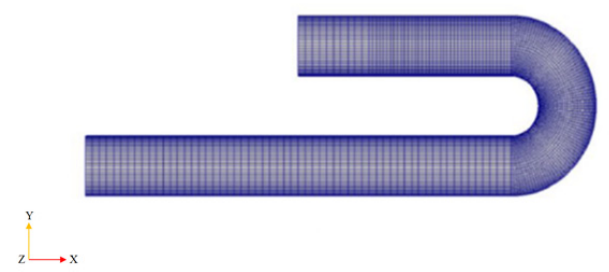
Figure 4 . Boundary conditions .